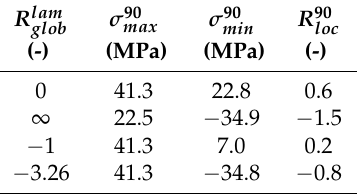
Table 3. Overview of the local maximum and minimum stress components ( σ 90 max and σ 90 associated local stress ratios R 90 90 ◦ -layer at different global applied stress ratios R lam